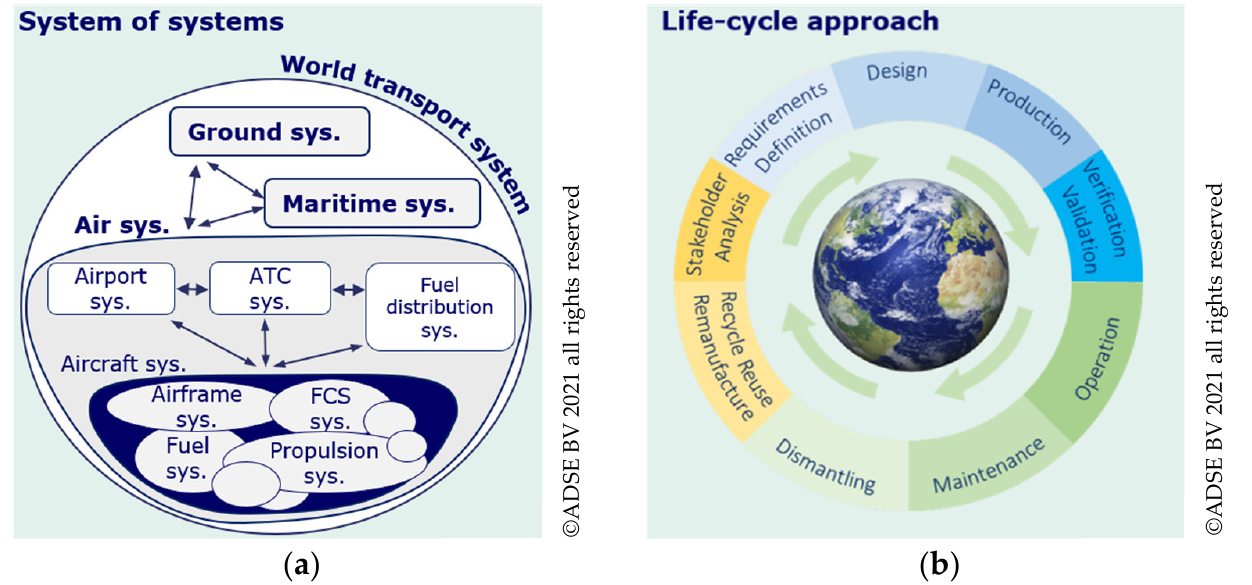
Figure 2. ( a ) System of systems and ( b ) life-cycle approach.